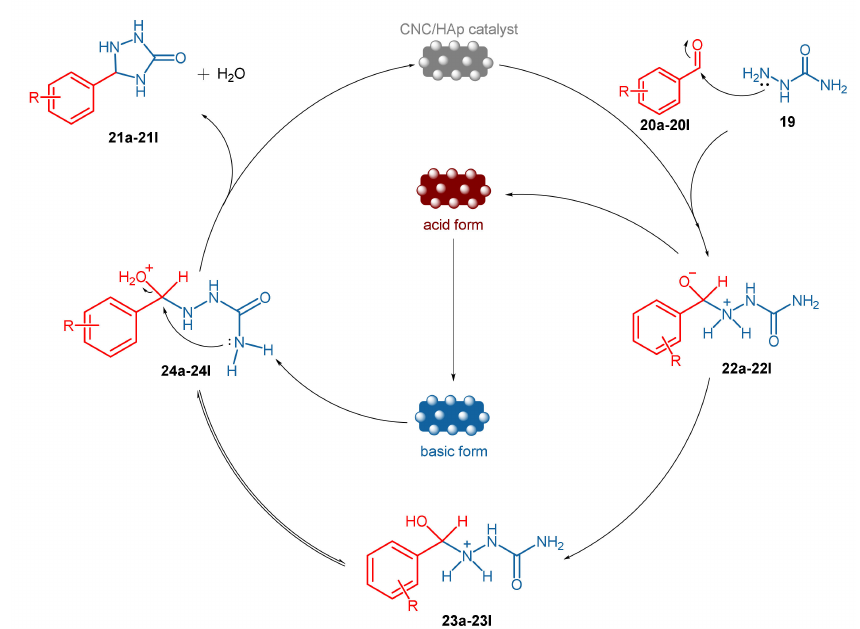
Figure 3. Proposed Mechanism for the cyclocondensation between semicarbazide 19 and aldehydes 20a–20l catalyzed by